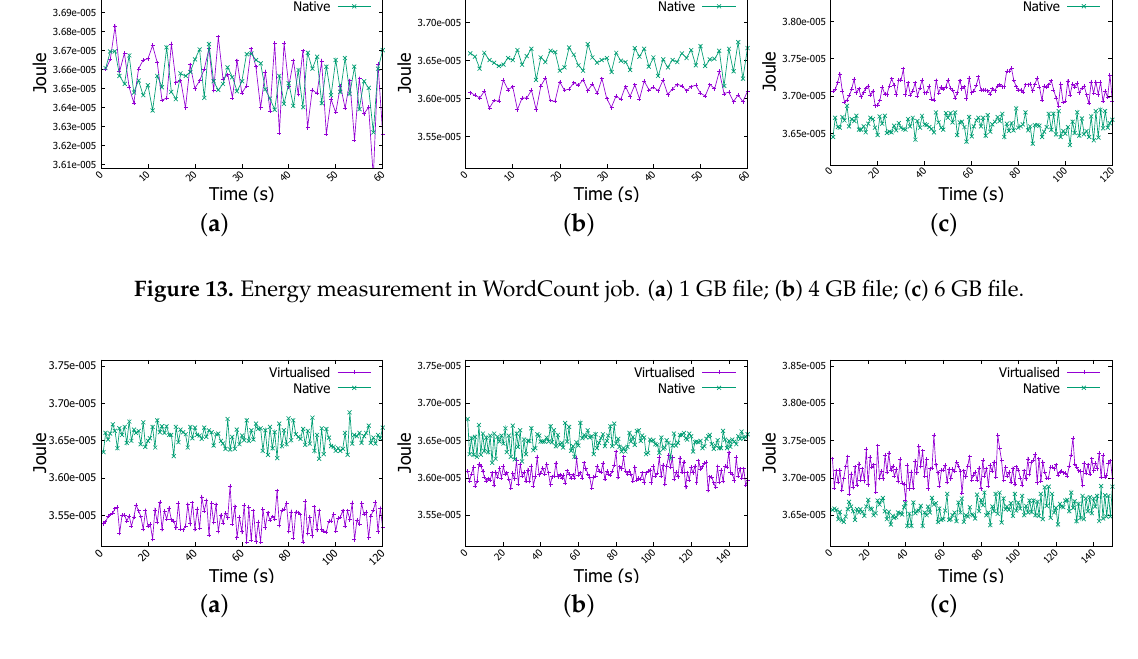
Figure 14. Energy measurement in Sort job. ( a ) 1 GB file; ( b ) 4 GB file; ( c ) 6 GB